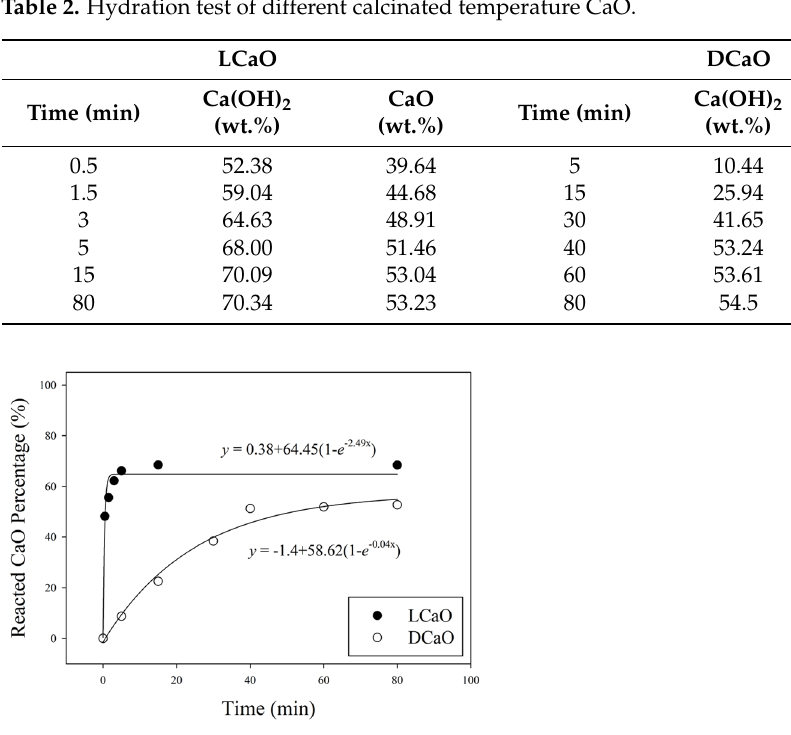
Table 2. Hydration test of different calcinated temperature CaO.